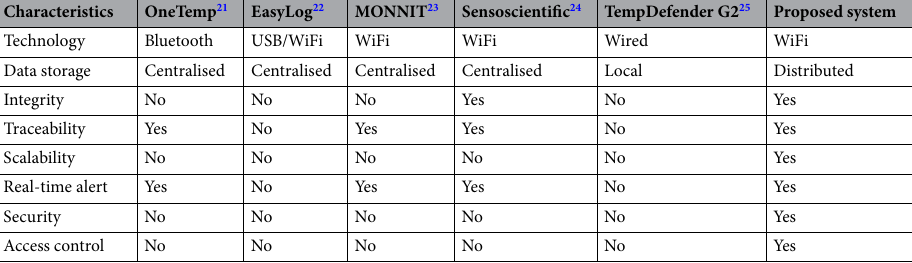
Table 2. Comparison with existing industry